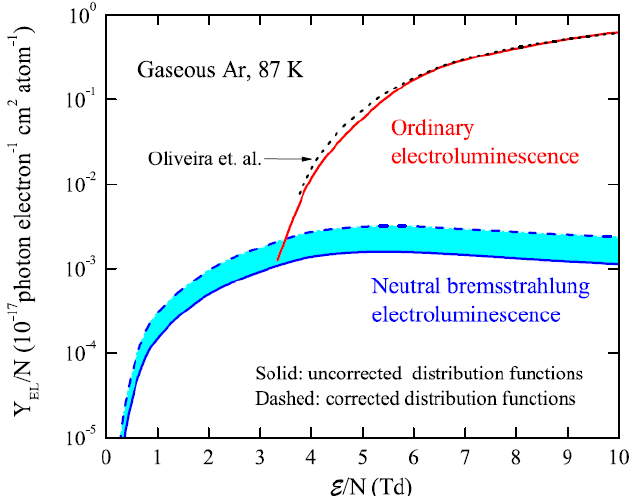
Figure 9. Reduced EL yield in gaseous Ar as a function of the reduced electric field, for neutral bremsstrahlung EL (below 1000 nm) calculated theoretically in [9], compared to ordinary (excimer) EL calculated in [16] (from [9], with permission from Elsevier).